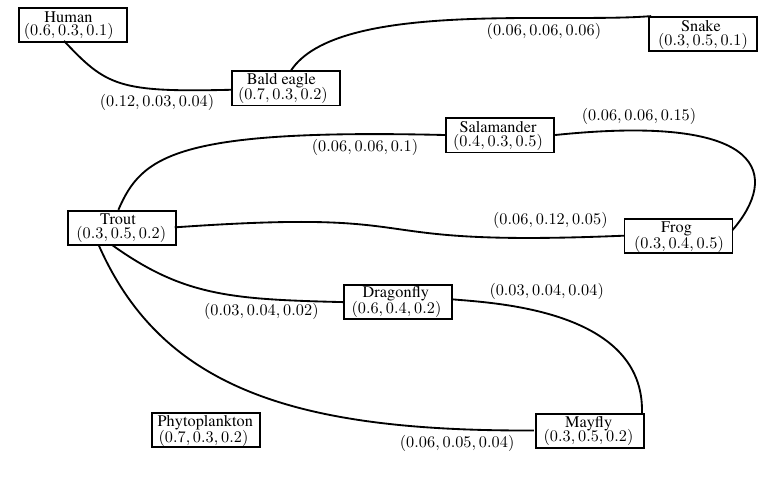
Figure 18. Corresponding